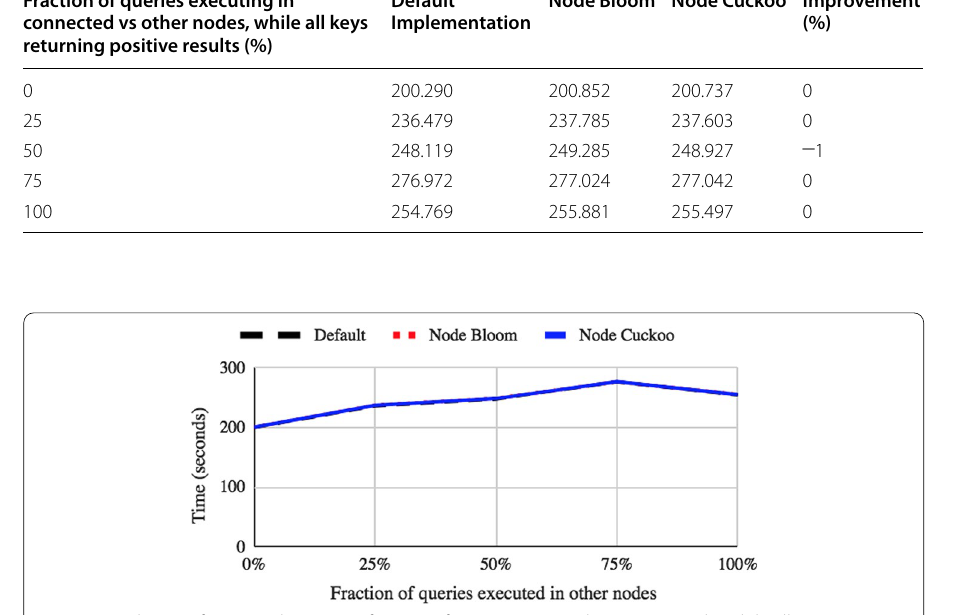
Table 9 Experimental results 2: lookup performance when remote nodes contain data against all queried partition keys. Query execution time in seconds Fraction of queries executing in connected vs other nodes, while all keys